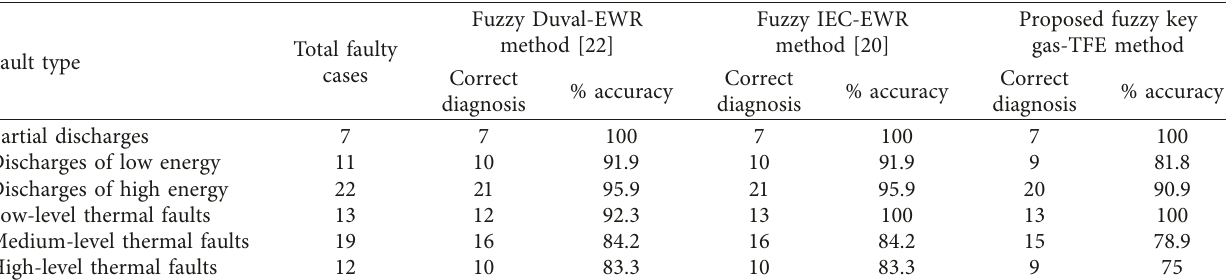
Table 6: Comparison of different fault detecting diagnostic approaches with respect to fault type.